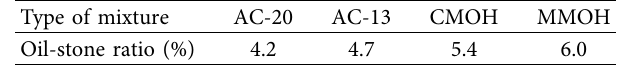
Table 3: Oil-stone ratio.